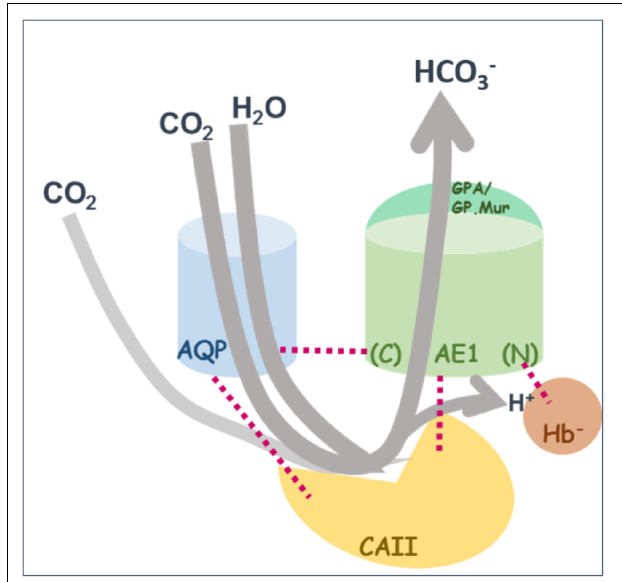
FIGURE 3 | A revised model for the “CO 2 -transport metabolon.” As illustrated in the cartoon diagram, the CO 2 -transport metabolon can be deemed as a transiently extended CAII machinery, which is built upon transient interactions among the four proteins: AQP1, erythroid AE1, CAII, and deoxy Hb − (shown by red dotted lines). The C -terminal and N -terminal regions of AE1 are indicated by ( C ) and ( N ). Illustrated here in gray arrow lines is the direction of the conversion reaction in systemic capillaries: CO 2 is converted into HCO 3 − , followed by export of bicarbonate and absorption of proton by Hb −